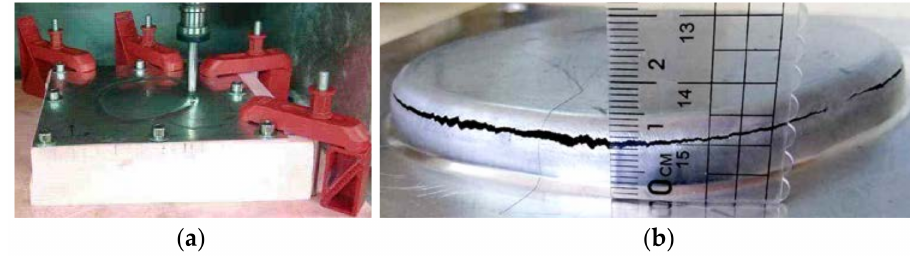
Figure 17. The single stage forming: ( a ) the forming process and ( b ) the formed part.